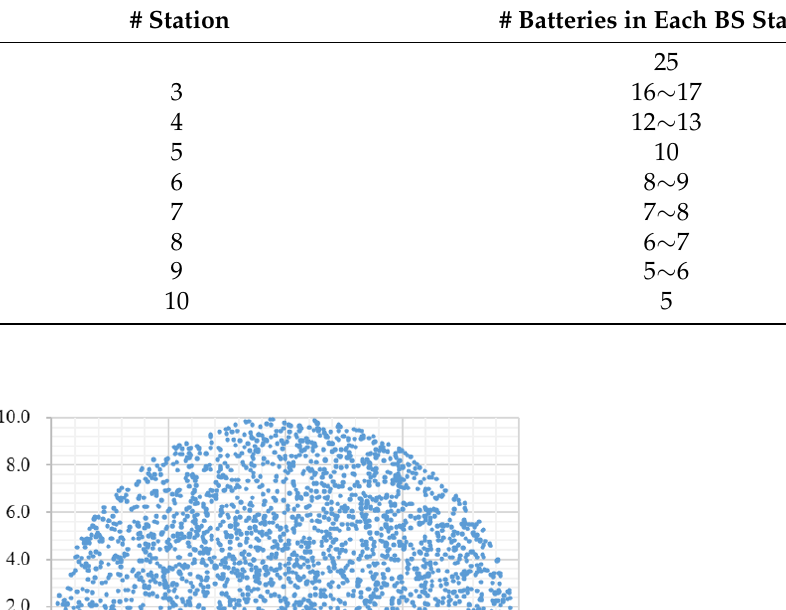
Table 5. The number of batteries in each BS station.